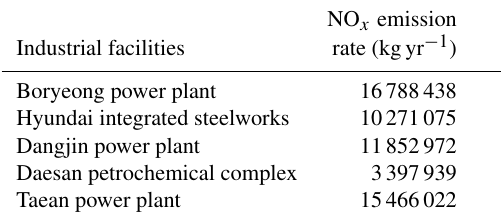
Table 5. NO x emission rates in 2016 from major industrial facil- ities in the Anmyeon region obtained from the Continuous Emis- sion Monitoring System of the Korea Environment Corporation (https://www.stacknsky.or.kr/eng/index.html, last access: 25 March